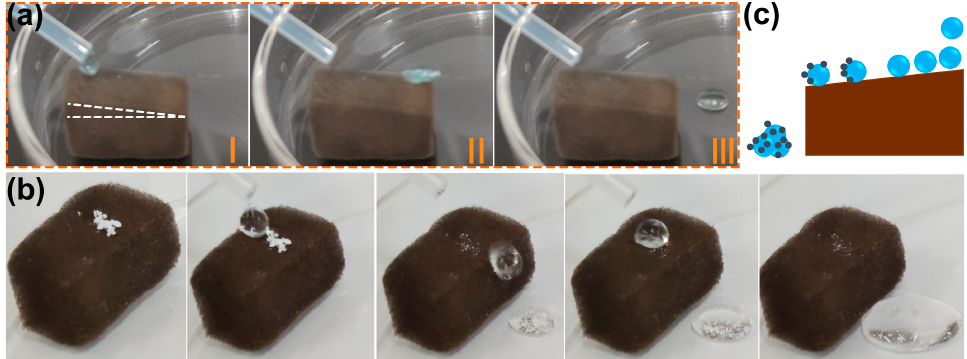
Figure 5. Photographs of ( a ) water-drop rolling test and ( b ) self-cleaning test on the composite sponge. ( c ) Schematic illustration of self-cleaning effect of the superhydrophobic F-ZIF-90@PDA-MF.